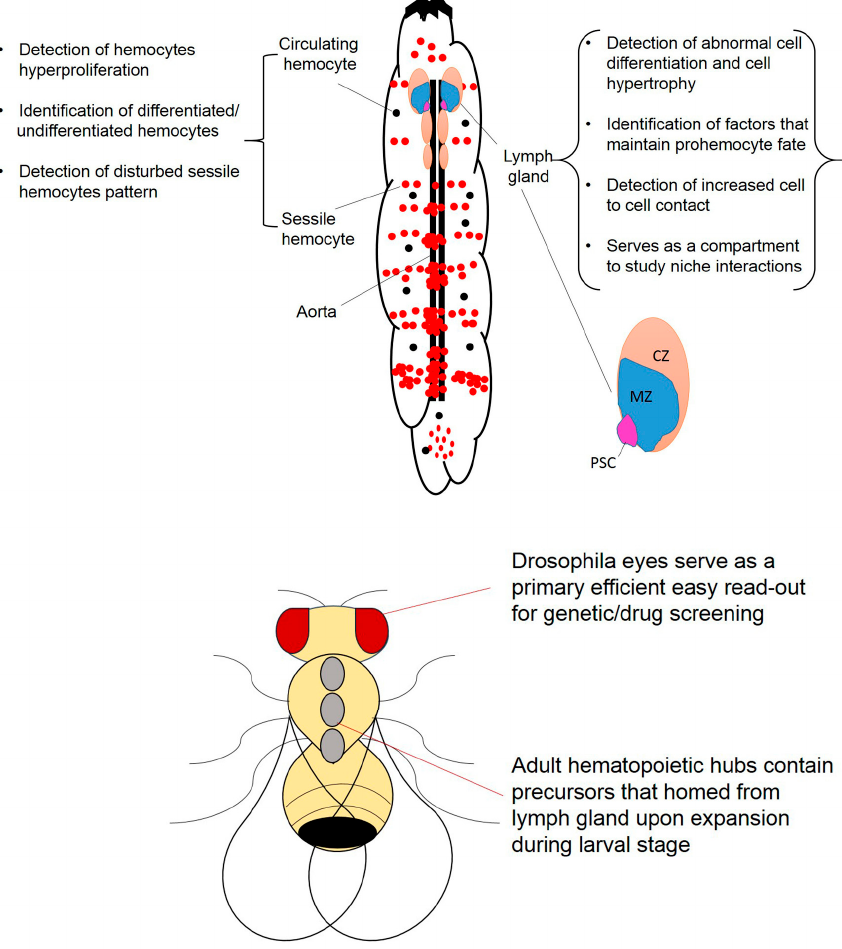
Figure 1. Summary of the hematopoietic compartments in fruit flies that can be used for leukemia studies. Drosophila larva serves as an efficient in vivo model with its easily accessible hematopoietic compartments and transparent cuticle that allows clear identification of oncogene-induced phenotypes. The adult fly serves in providing a primary efficient read-out for genetic and chemical screening. The larval lymph gland and hematopoietic hubs in the larvae and adult respectively shape a simple mammalian bone marrow that can be exploited in leukemia research. MZ: medullary zone (blue); CZ: cortical zone (orange); PSC: posterior signaling center (purple).